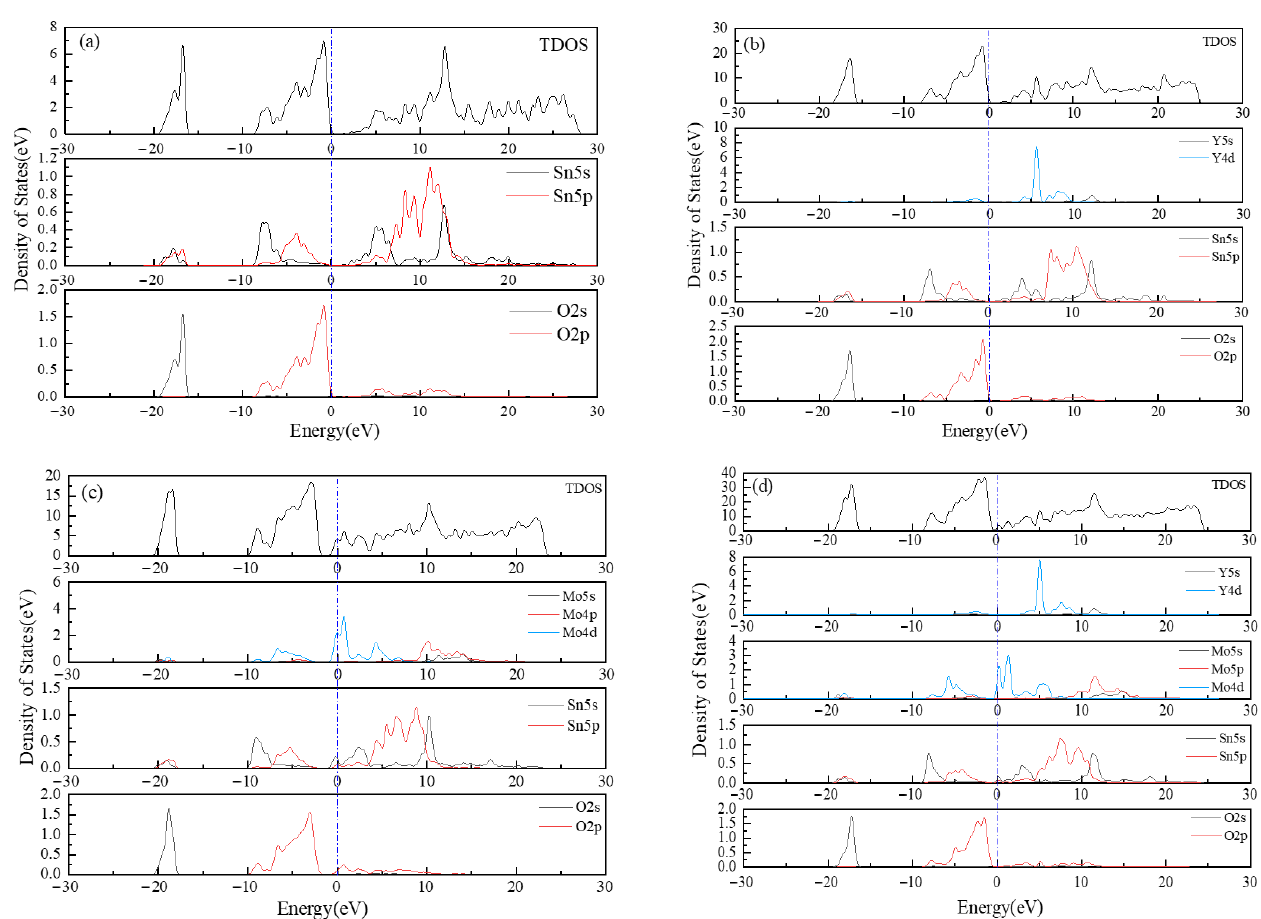
Figure 3. Density of states: ( a ) SnO 2 ; ( b ) Y-doped SnO 2 ; ( c ) Mo-doped SnO 2 ; ( d ) Y-Mo co-doped SnO 2 . Figure 3a is the density of states diagram of undoped SnO 2 ; it can be seen that the peak appeared at the deep level ( − 19.5– − 15.6 eV), which is mainly due to the energy pro- vided by the O-2s state. This is far away from the Fermi energy level and therefore has little effect on conductivity. The valence band near the Fermi level (−8.4–0.3 eV) had a peak, which was mainly provided by the O-2p state in addition to a small amount from